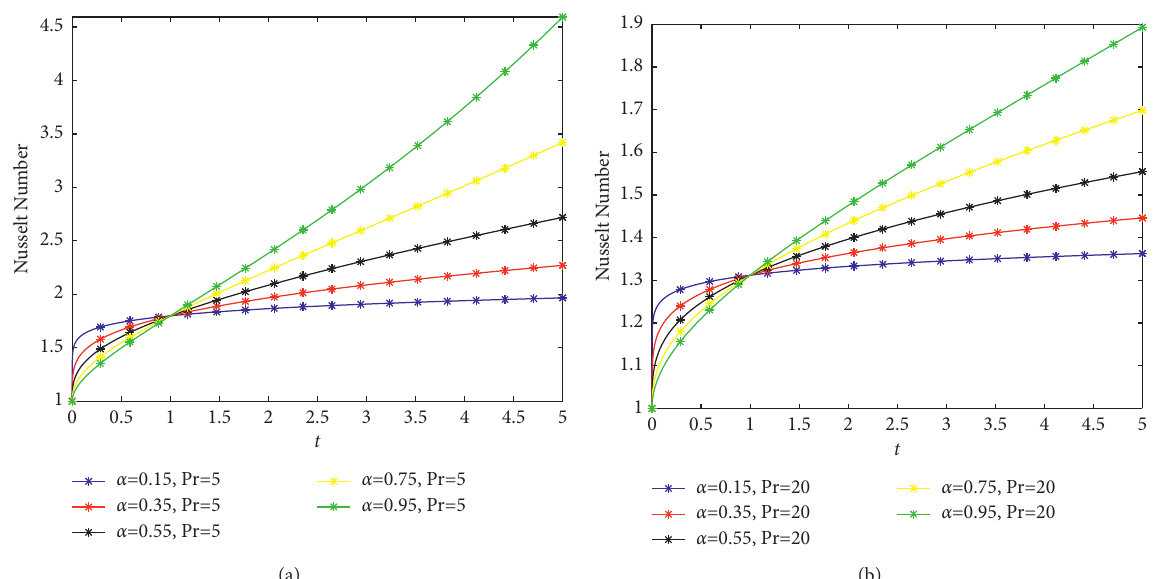
Figure 16: Nusselt number for different values of order α